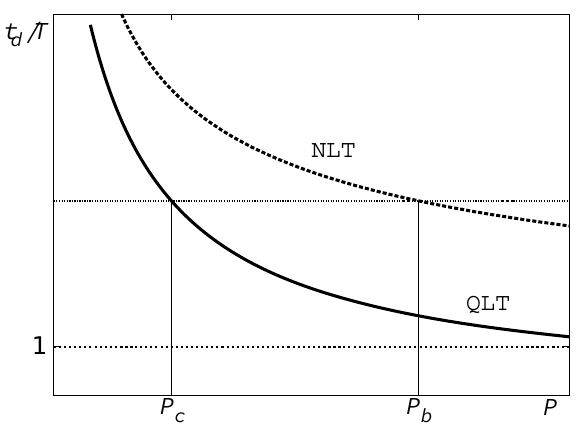
Fig. 7. Time of diffusion as a function of wave power. Here P 1 and P 2 are the critical wave powers for the applicability of the FPK equation in QLT and NLT,